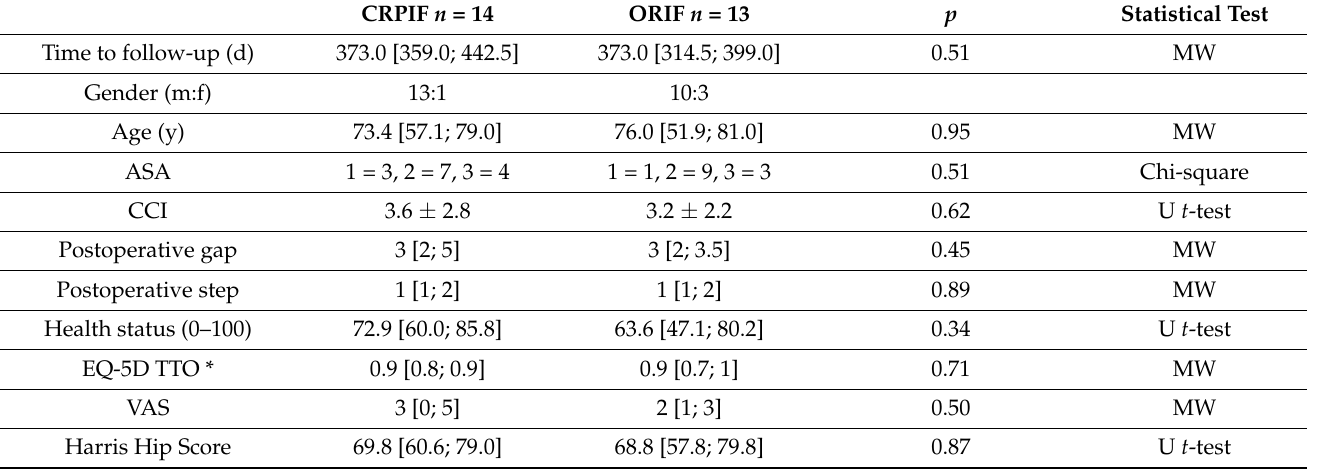
Table 2. Demographics, quality of life, and functional outcome of patients who completed their follow-up. * Two patients refused to fill out the EQ-5D TTO. Gaussian-distributed data (CCI, health status, VAS, and Harris Hip Score) are presented as mean [95% CI]. Non-Gaussian-distributed data (time to follow-up, age, postoperative gap and step, and EQ-5D TTO) are presented as median [IQR25-75]. Open reduction and internal fixation, ORIF; closed reduction and percutaneous internal fixation, CRPIF; confidence interval, CI; interquartile range 25–75%, IQR25-75; days, d; male, m; female, f; American Society of Anesthesiologists grading, ASA; Charlson Comorbidity Index, CCI; range of motion, ROM; timed up and go, TUG. Mann–Whitney U test, MW; unpaired test, U t -test; chi-square test,